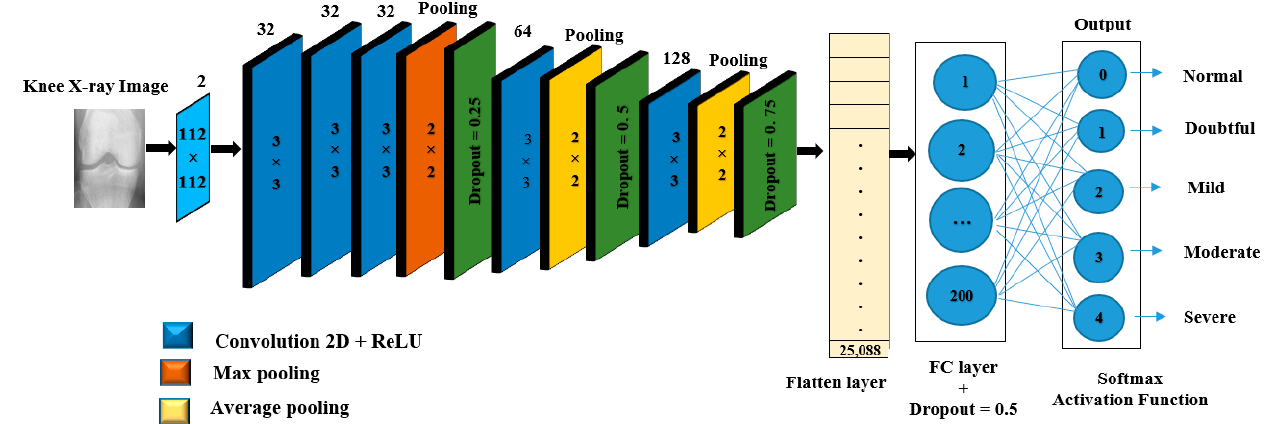
Figure 7. Proposed CNN architecture. Table 2. The configuration detail of the proposed model with their output size.